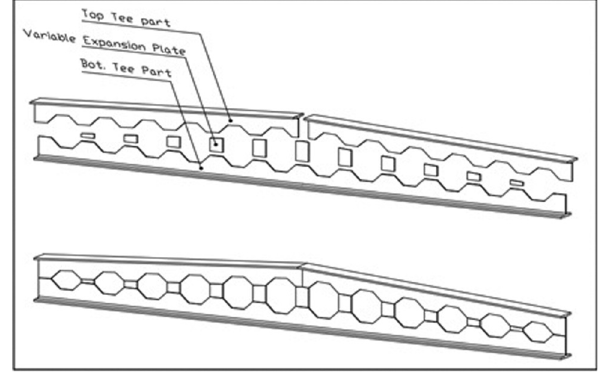
Figure 2: Fabrication of TCBs by placing variable expansion